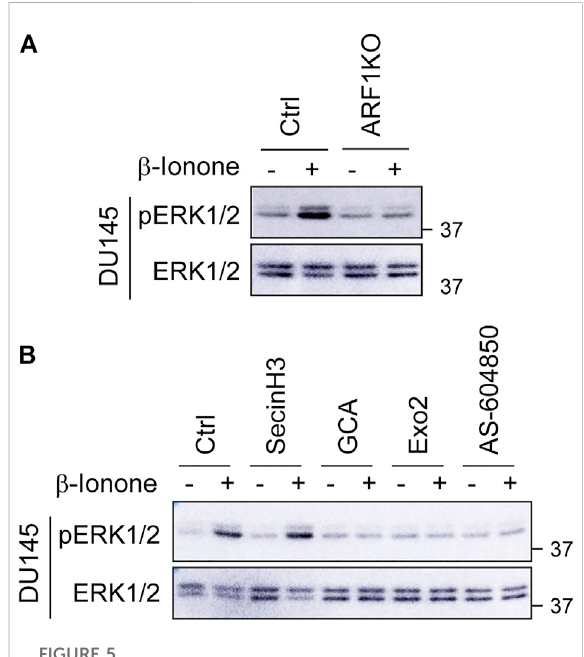
FIGURE 5 KO and inhibition of ARF1 abolish ERK1/2 activation by OR51E2. (A) Effect of CRISPR-Cas9-mediated depletion of ARF1 on ERK1/2 activation by β -ionone in DU145 cells. The cells were transiently transfected with CRISPR-Cas9 KO plasmids targetinghumanARF1,starvedfor48 handthenstimulatedwith β - ionone at 100 μ M for 5 min. (B) Effect of ARF1 inhibitors on ERK1/ 2 activation by β -ionone in DU145 cells. The cells were starved for 48 h and treated with secinH3 (100 μ M), GCA (30 μ M) or Exo2 (60 μ M) for 30 min before stimulation with β -ionone. AS-604850 treatment (2.5 μ M for 6 h) was used as a positive control. The Western blots shown in each panel are representatives of at least three